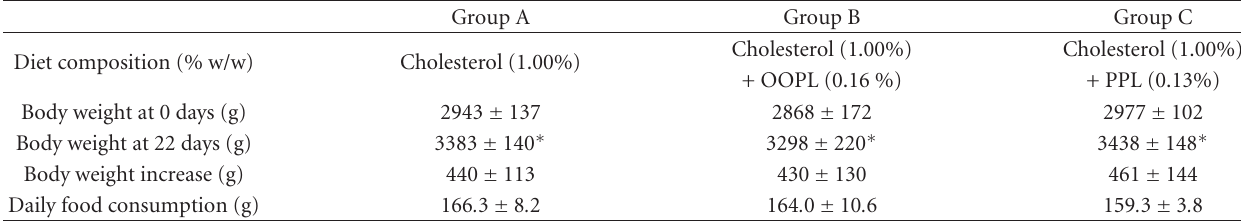
Table 2: Body weight, daily food consumption and diet composition of experimental groups.